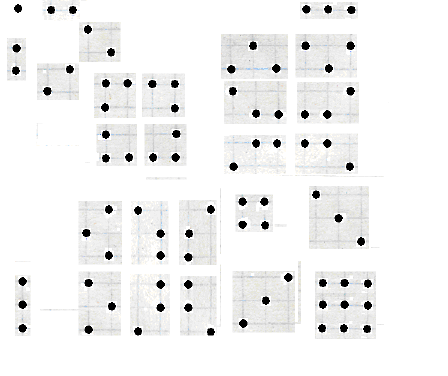
Figure 13. Hierarchy of small isolated